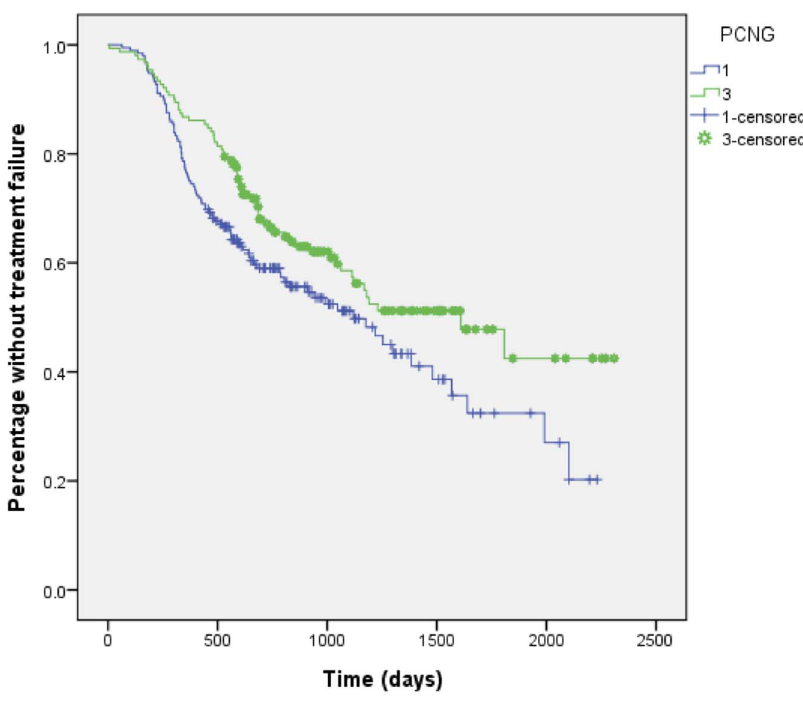
Figure 4. Kaplan-Meier plot showing the time to treatment failure to 1- or 3-dose benzathine penicillin G regimen (Log rank test, P =0.026).